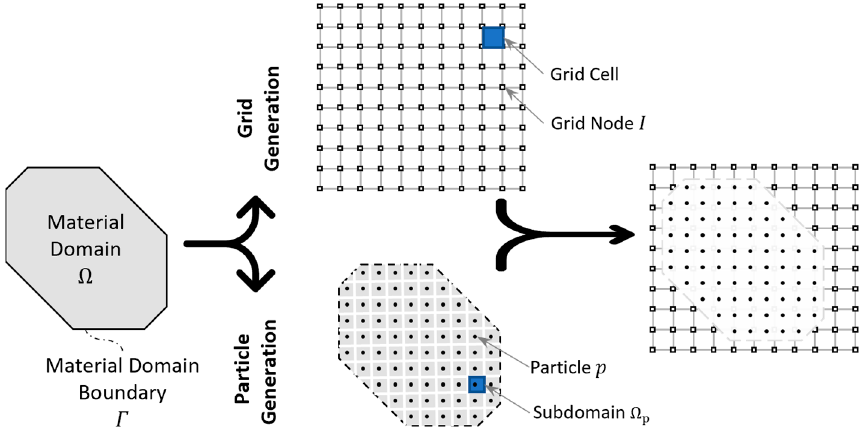
Figure 1. Schematic diagram of typical MPM discretization.